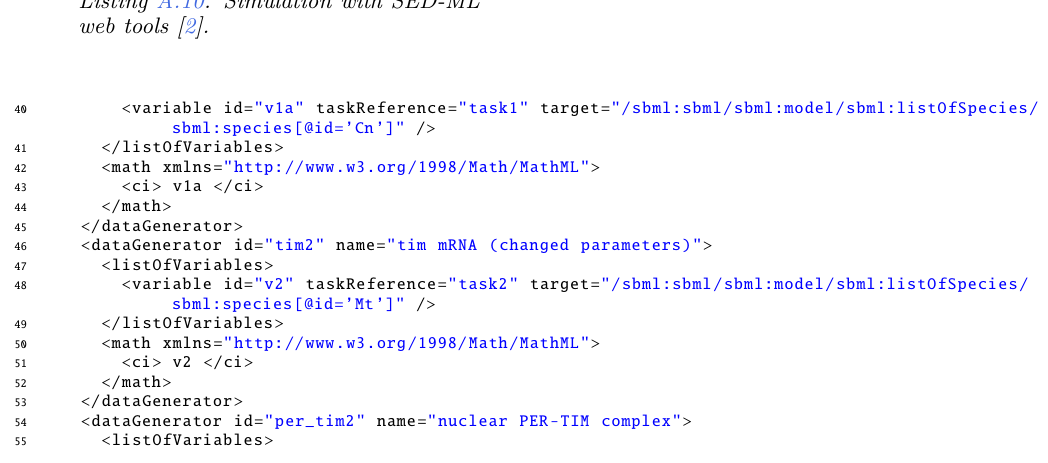
Figure A.18: Simulation with tellurium